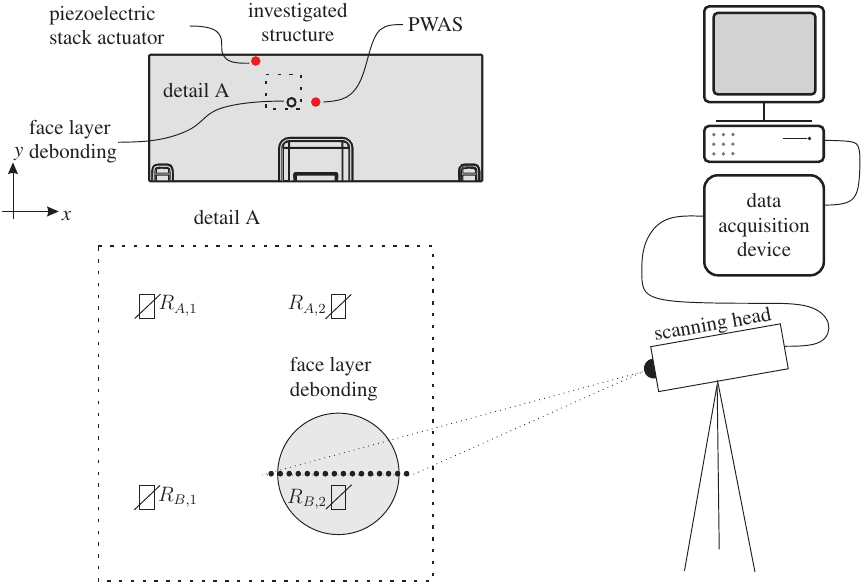
Figure 3. Experimental set-up of the scanning laser Doppler vibrometer measurements (detail A is a scaled magnification of the area of interest).